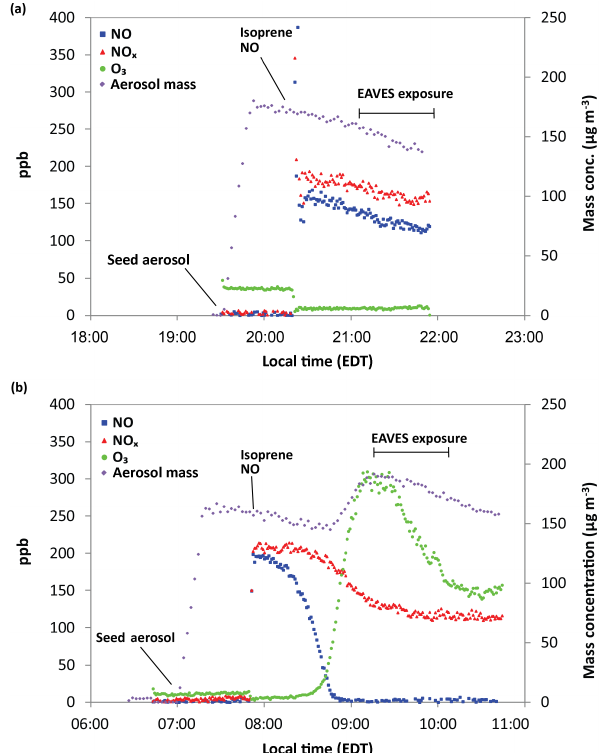
Figure 1. Aerosol mass concentration and gas-phase product con- centrations over time for (a) dark control chamber experiment and (b) photochemically produced isoprene-derived SOA exposure chamber